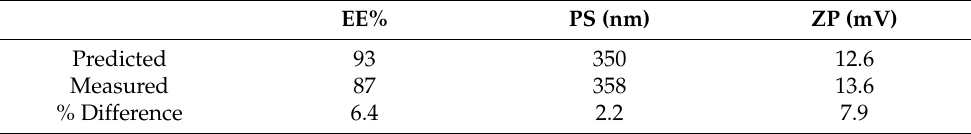
Table 2. The predicted and estimated values of different responses of the optimized formulation (F7).